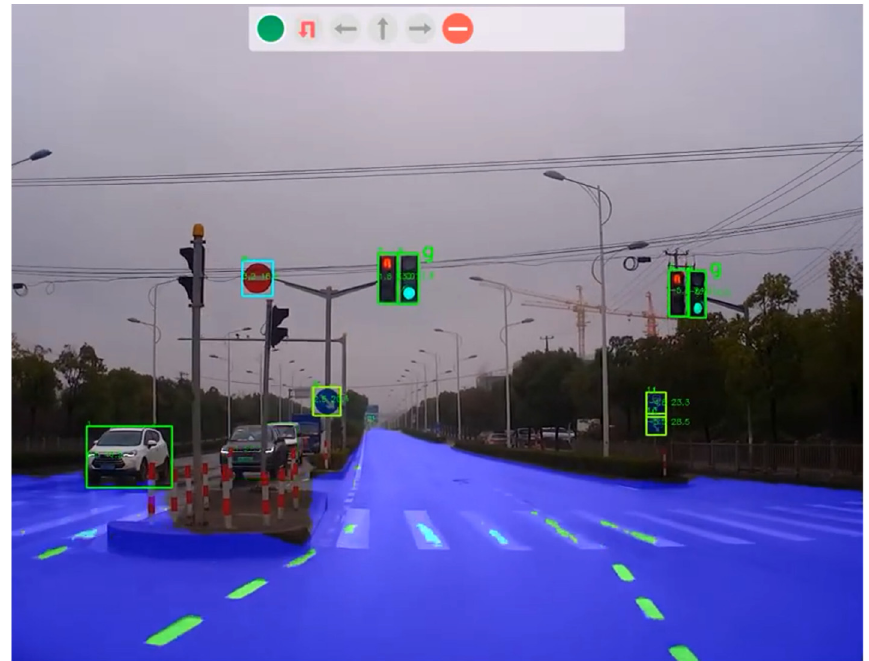
Figure 10. TSR algorithm running on KITTI dataset—example 1.